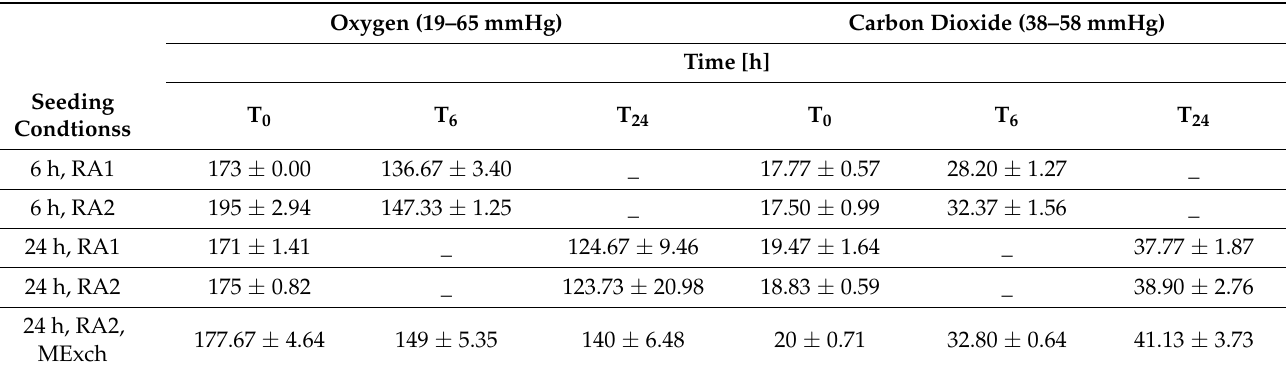
Table 2. Analysis of oxygen and carbon dioxide in cell medium at different time points during different seeding conditions. Values are provided as means with standard deviation (SD) from independent triplicates. Reference values for venous blood, as prospectively perfused through the BHL, are in brackets [30]. RA1: rotational axis 1, RA2: rotational axis 2, MExch: medium